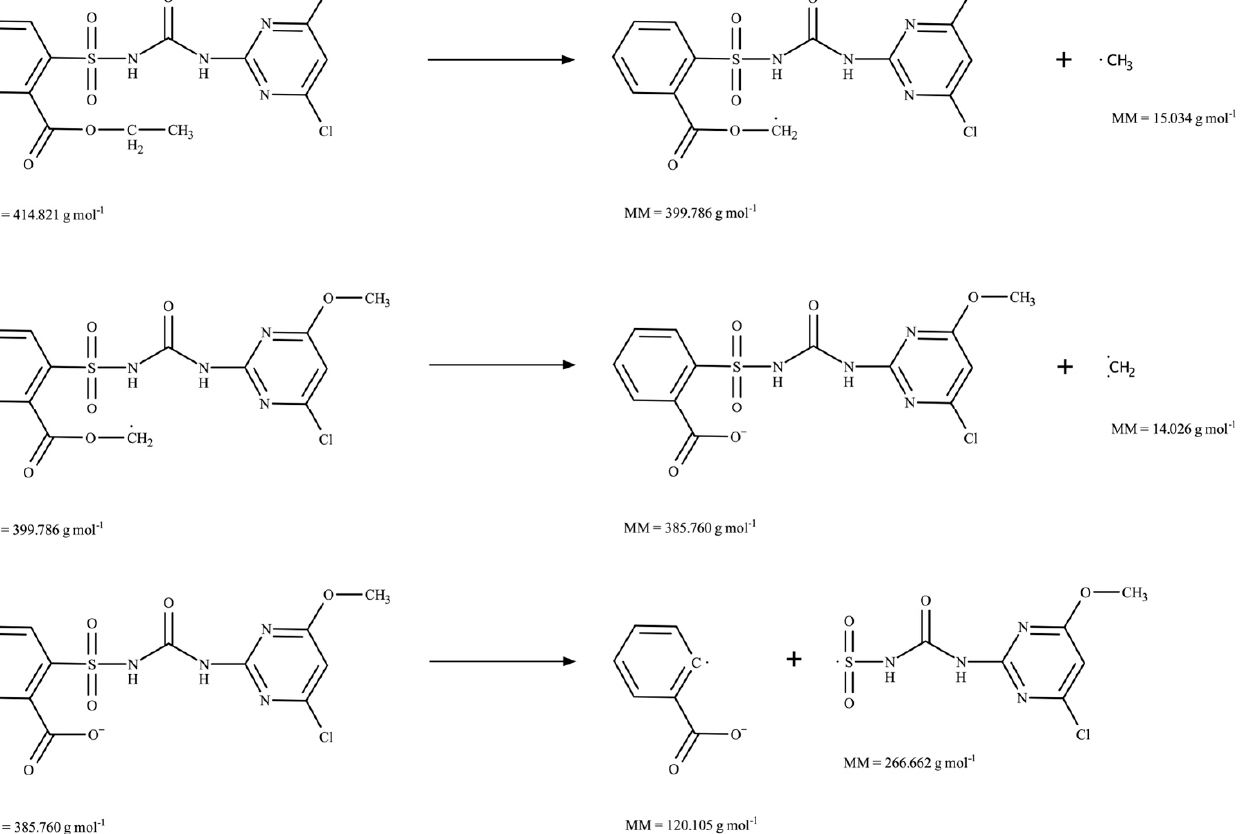
Figure 3. Mechanism of degradation proposed for the chlorimuron-ethyl herbicide to elucidate the chemical reactions during the electroflotation treatment and the degradation products formed. MM indicates molecular mass.